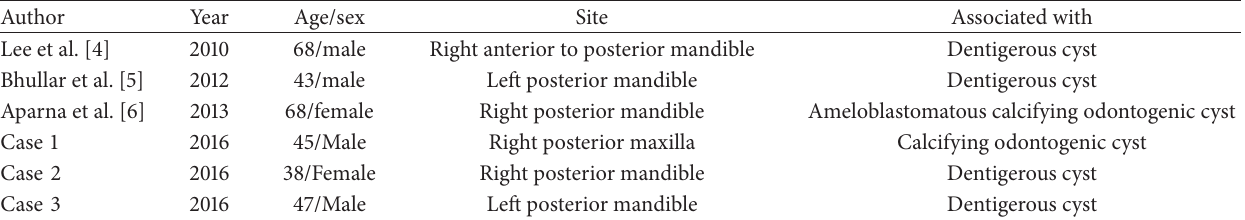
Figure 3: (a) CT scan revealed a well-defined radiolucency (30 × 14 mm in size) present on left angle of mandible region; (b) on incisional biopsy, 2-3-cell layer thick nonkeratinized stratified squamous cystic epithelial lining which showed proliferation in few areas associated with underlying inflammation (H/E 4x); (c) on excisional biopsy cholesterol clefts in cystic wall (H/E 10x); (d) cholesterol clefts in cystic wall (H/E 40x). Table 1: Reported cases of cholesterol granuloma in association with odontogenic